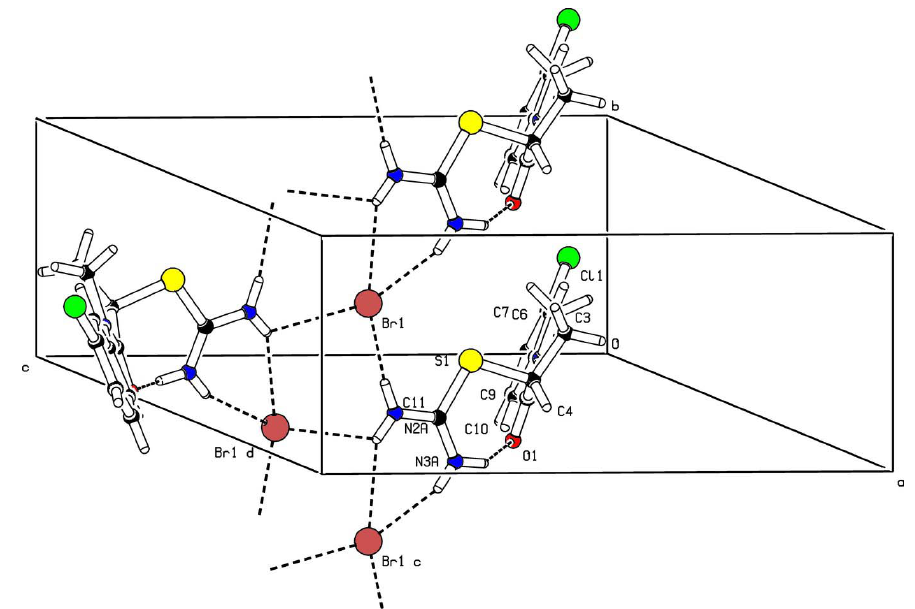
Figure 2 View of the motif of the structure with the hydrogen bonding.